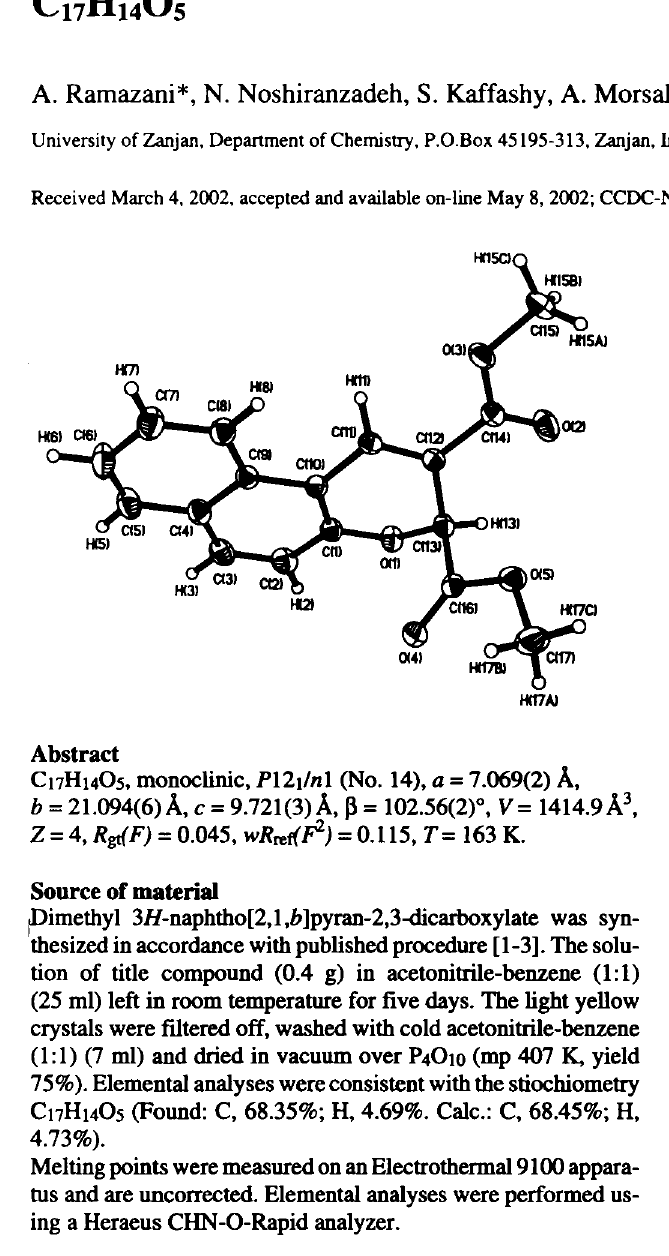
Table 2. Atomic coordinates and displacement parameters (in Â 2